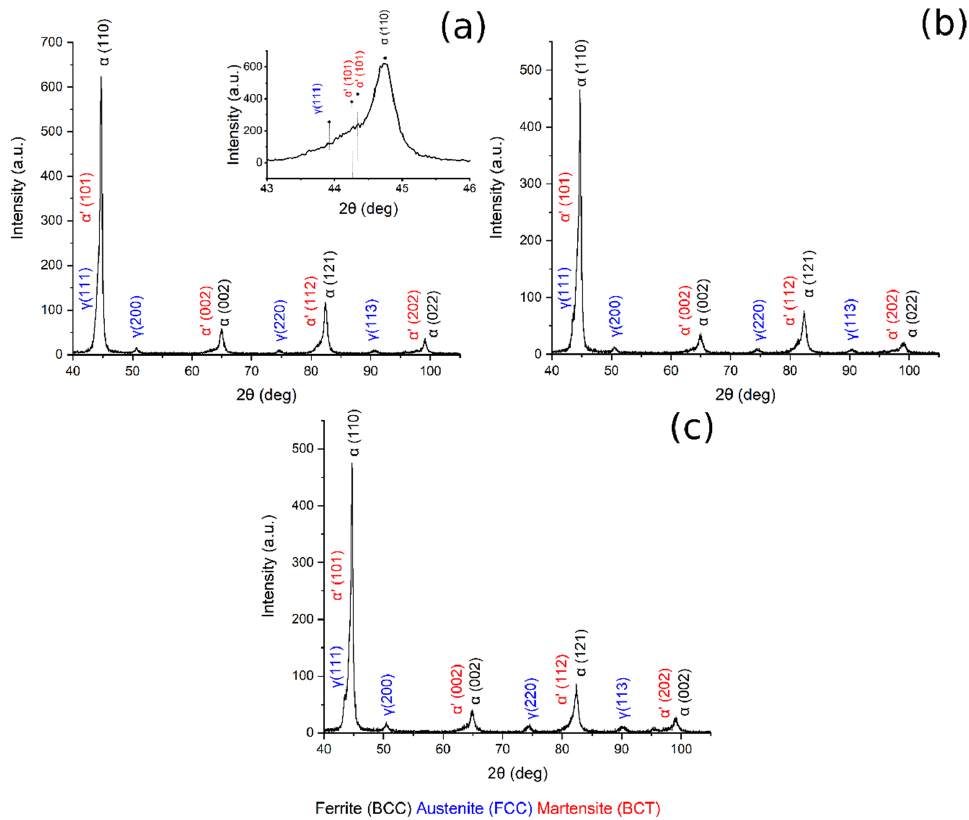
Figure 7. XRD pattern ( a ) 780 ◦ C + 350 ◦ C, in the box upon on the right can be found a zoom of the pattern in the range 43–46 ◦ , ( b ) 830 ◦ C + 350 ◦ C, ( c ) 850 ◦ C + 350 ◦